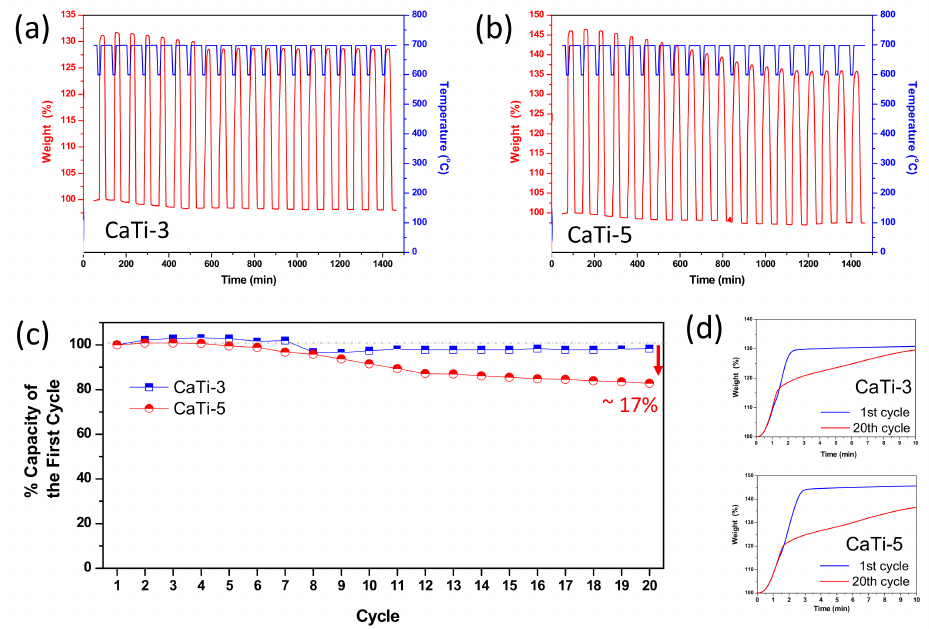
Figure 5. Twenty cyclic repeating experiment results of CaTi-3 ( a ) and CaTi-5 ( b ); percentage of capture capacity of each cycle to the first cycle ( c ), and the carbonation performance of the first and the twentieth experiment of CaTi-3 (up) and CaTi-5 (down) ( d